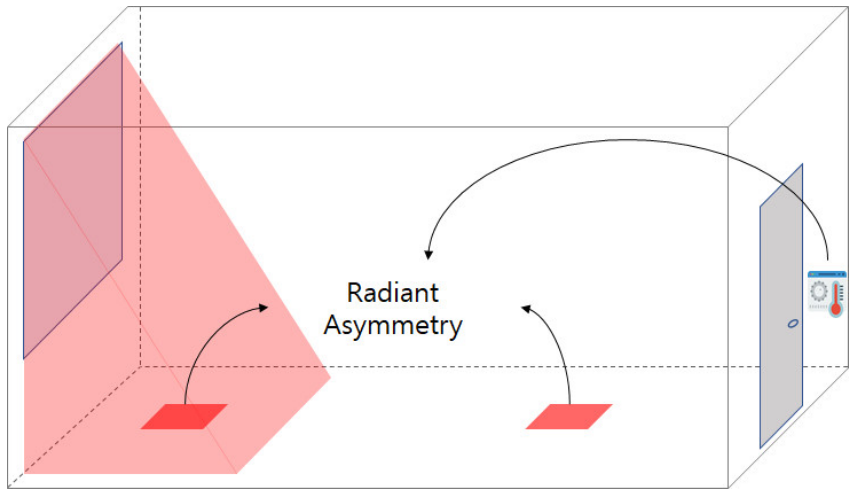
Figure 2. Radiant asymmetry.